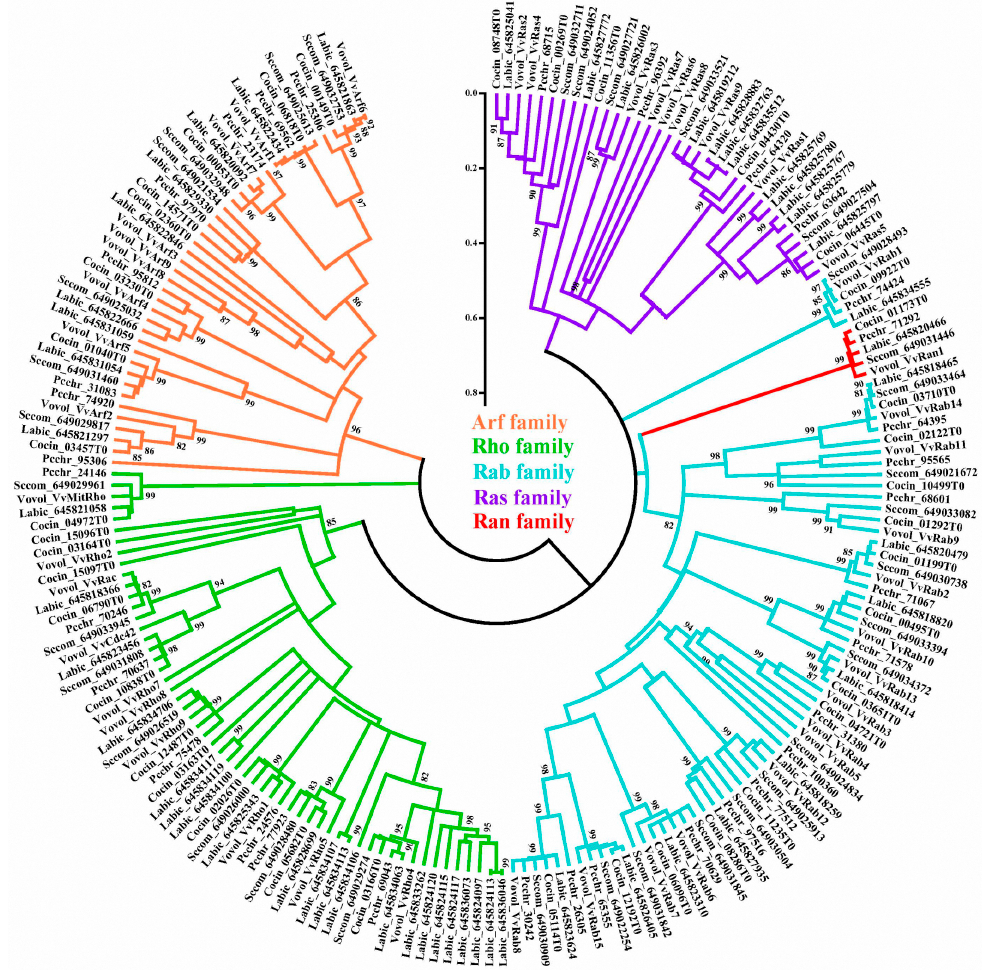
Figure 2. Phylogenetic analysis of small GTPases of 5 basidiomycetes. The clades were labeled with the abbreviated Latin species name, followed by “_predicted gene ID” except for the proteins from Volvariella volvacea , which were labeled with “abbreviated Latin species name_protein